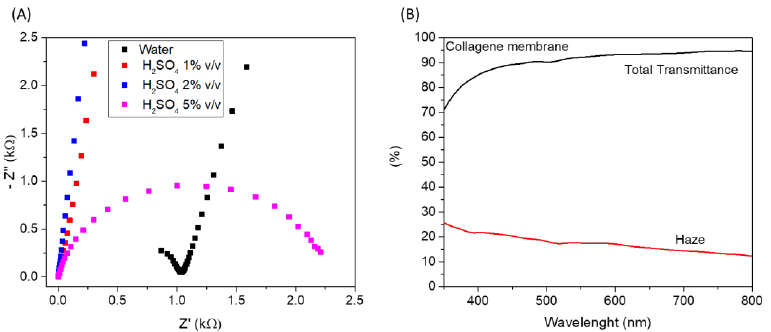
Figure 7. ( A ) Nyquist plots of electrochemical impedance spectra of the different membranes measured at 0 V; ( B ) Total transmittance and haze of cross-linked collagen membrane impregnated with H 2 SO 4 1% ( v / v ).